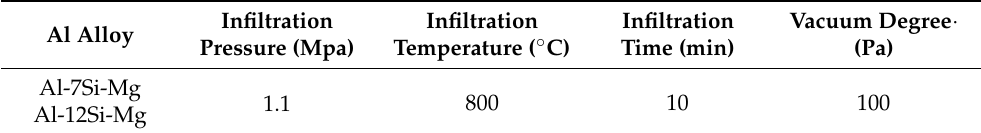
Table 3. Technological parameters of liquid Al infiltration process. Al Alloy